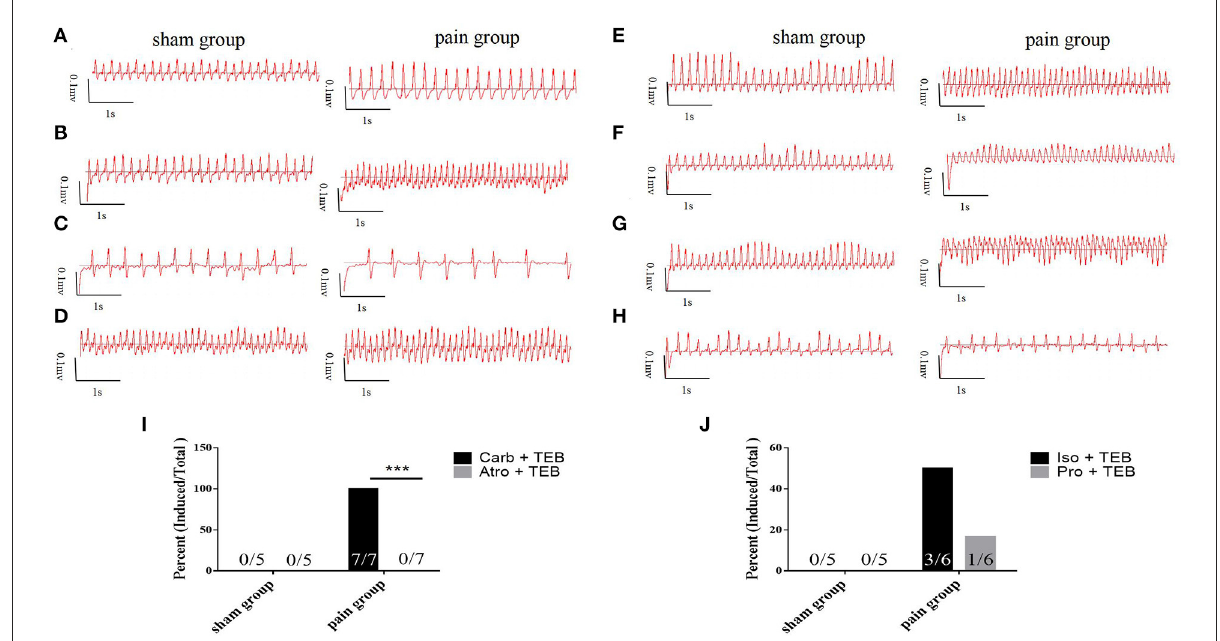
FIGURE4 Vagal effects (A – D) and sympathetic effects (E – H) on atrial fibrillation. (A) The basic ECG in sham and pain groups; (B) the ECG after transesophageal burst pacing (TEB) in sham and pain groups; (C) the ECG after TEB with carbachol pretreatment in sham and pain groups; (D) the ECG after atropine/carbachol and TEB in sham and pain groups; (E) the basic ECG in sham and pain groups; (F) the ECG after TEB in sham and pain groups; (G) the ECG after TEB with isoproterenol pretreatment in sham and pain groups; (H) the ECG after propranolol/isoproterenol and TEB in sham and pain groups; (I) the AF induced percent pretreated, respectively with carbachol and atropine/carbachol after TEB in sham and pain groups; and (J) the AF induced percent pretreated, respectively with isoproterenol and propranolol/isoproterenol after TEB in sham and pain groups. The results are expressed as numbers and percentages. Histograms represent percent. *** represents p < 0.001 (two-tailed Fisher’s exact test).